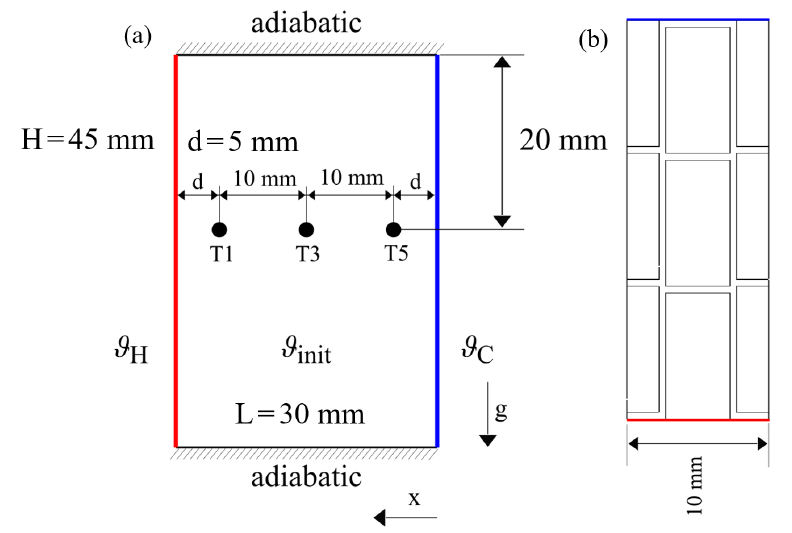
Figure 14. Simulation domain with boundary conditions from ( a ) sideview and ( b ) topview. The fins have been omitted in the side view ( a ) to increase